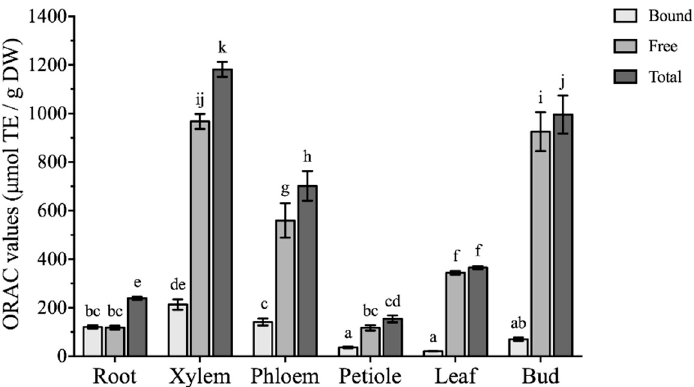
Figure 4. The ORAC values of different vegetative parts from Boehmeria nivea L. (mean ± SD, n = 3). Bars with different letters indicate significant differences among the samples (p <